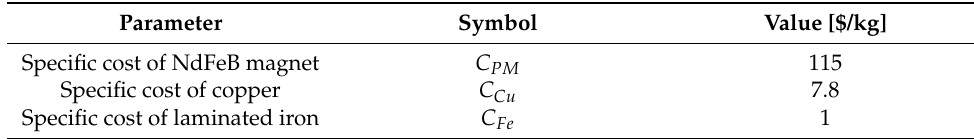
Table 5. Specific costs of active materials